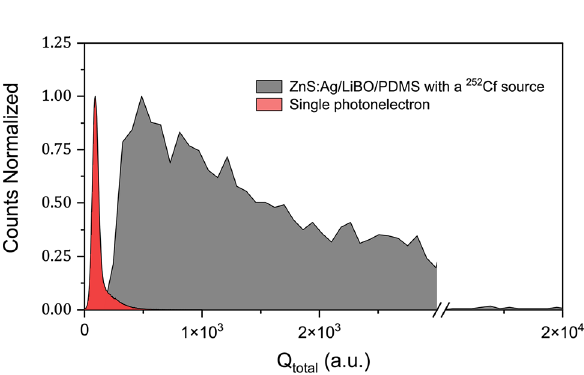
Table 1. Experimental and simulated thermal neutron efficiencies registered by three of the ZnS:Ag/LiBO- based detectors, using the 252 Cf source moderated with 6 cm of polyethylene.